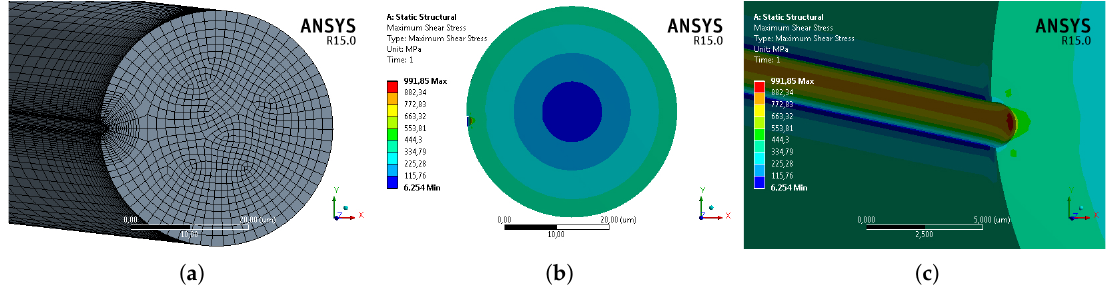
Figure 14. FEA applied to the case h = 20 r : ( a ) mesh; and ( b , c ) shear stress.